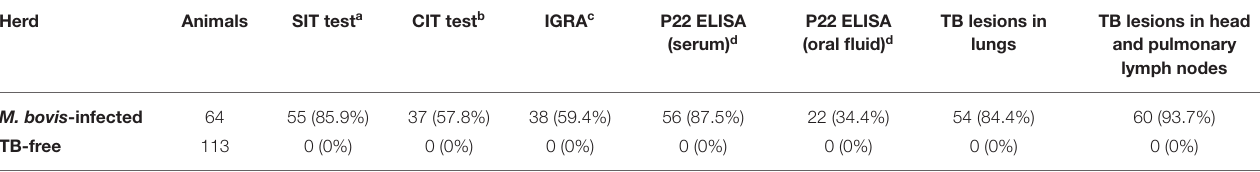
TABLE 2 | Summary of the ante-mortem tuberculosis (TB) diagnostic tests and post-mortem analysis in the goats under study. Herd